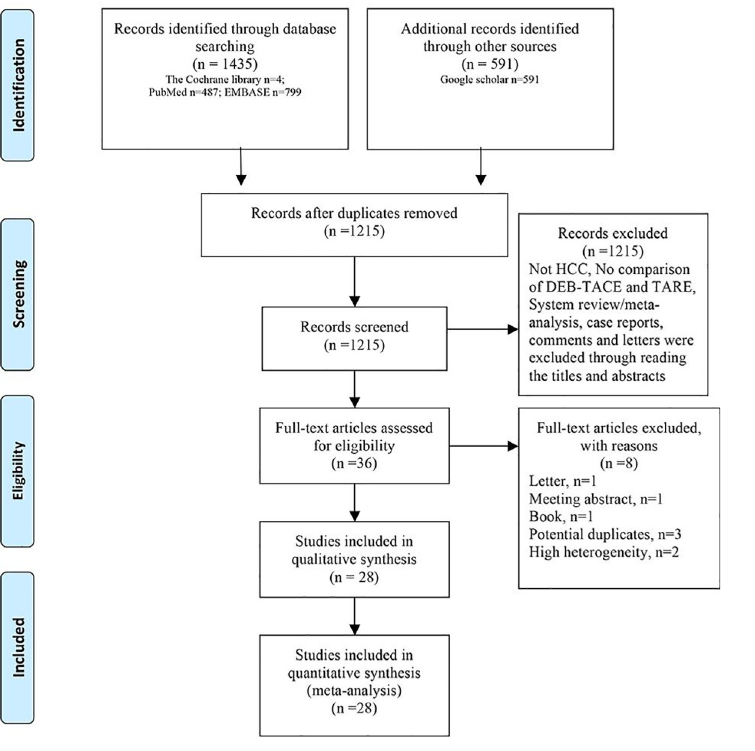
Fig 1. Flow chart depicting the study selection